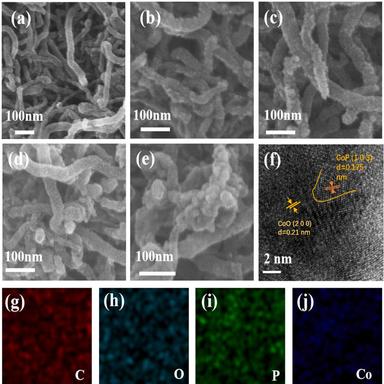
SEM images of (a) CNT, (b) Co3O4-CNT, (c) CoO-CoP-CNT, (d) CoP-CNT and (e) CoO-CNT, TEM image of (f) CoO-CoP-CNT, SEM images of (g)~(j) EDS maps of CoO-CoP-CNT.